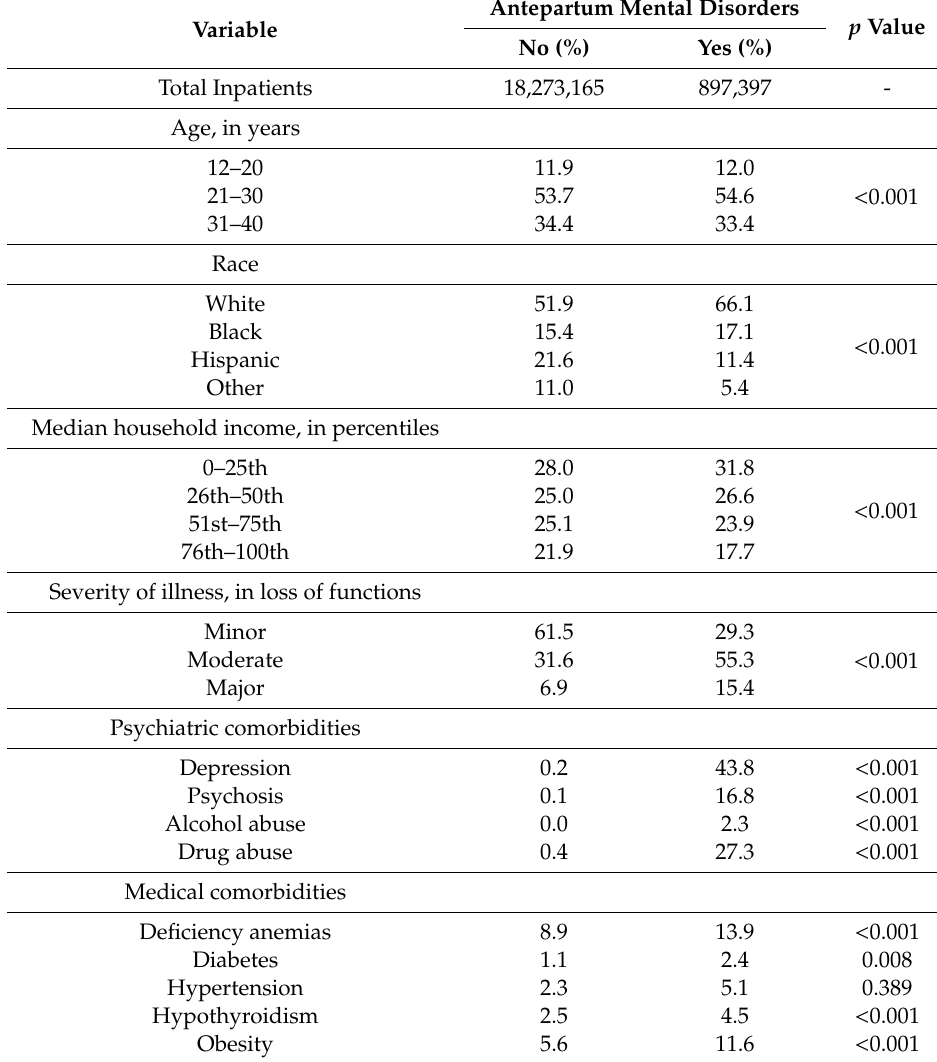
Table 1. Demographic predictors and comorbidities in pregnant inpatients with antepartum mental